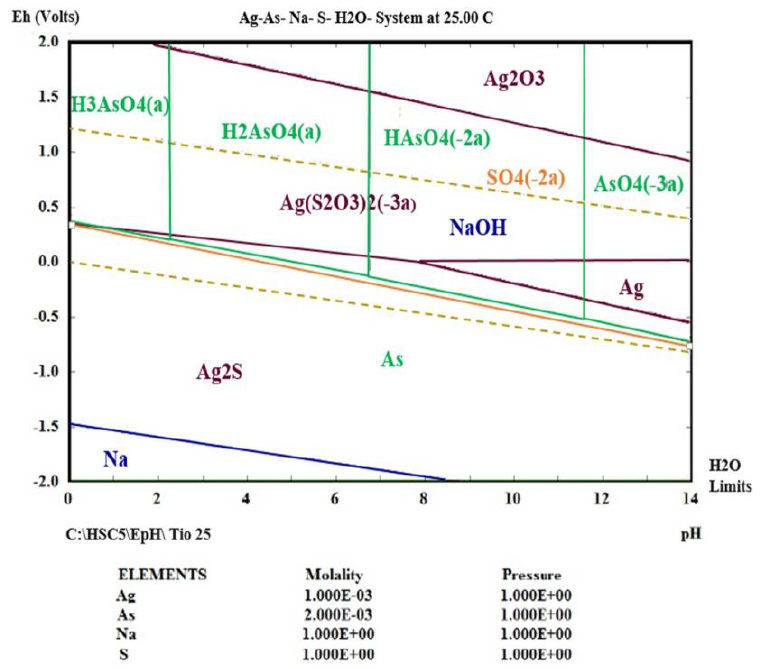
Figure 6. Diagram of the Eh-pH for the Ag–As–S–H 2 O system at 298 K.